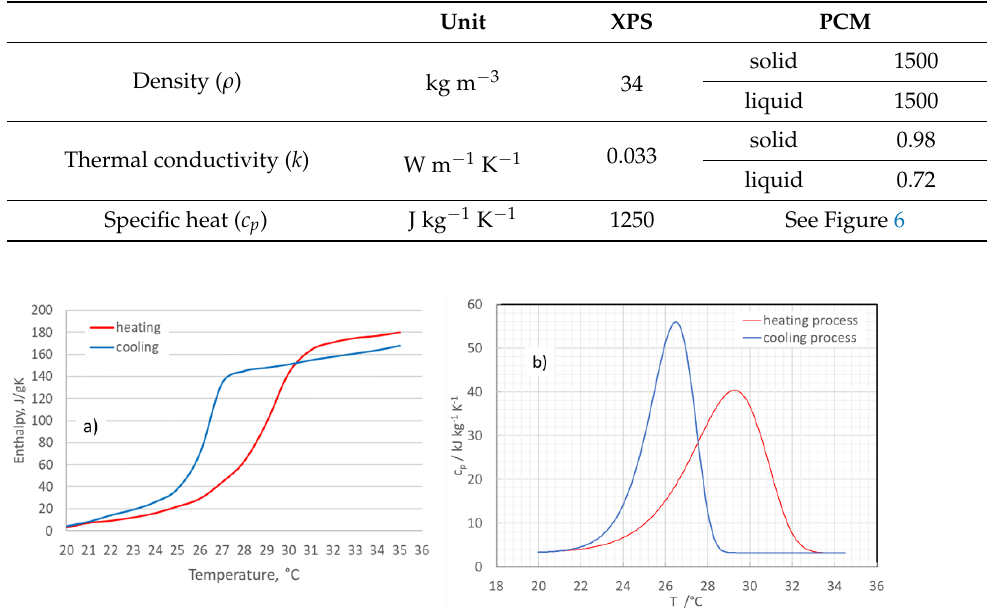
Figure 6. ( a ) Enthalpy data received from the PCM provider Climator Sweden AB; ( b ) Specific heat ( c p /(kJ/kgK)) of the PCM (Climsel 28) used in this study as a Weibull 2 function of temperature.